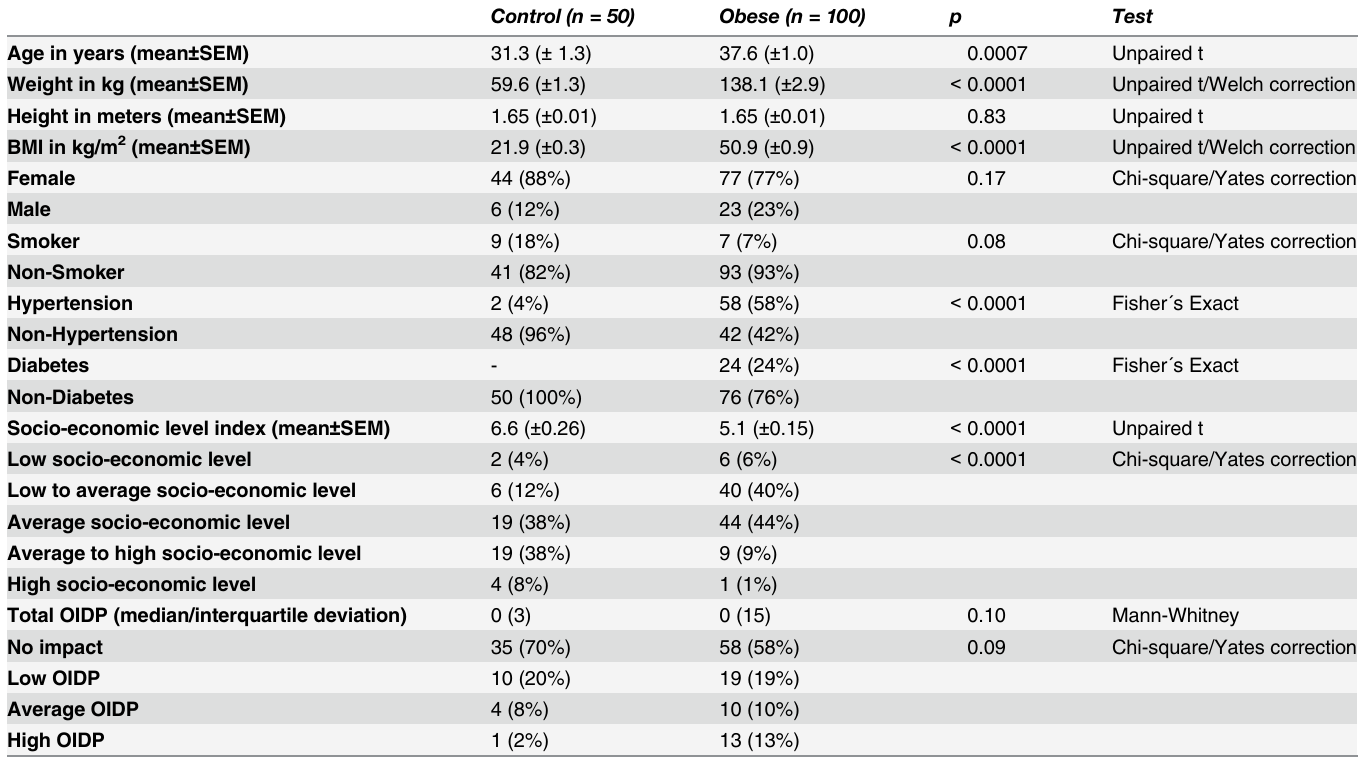
Table 1. Demographics and the anthropometric assessment of both